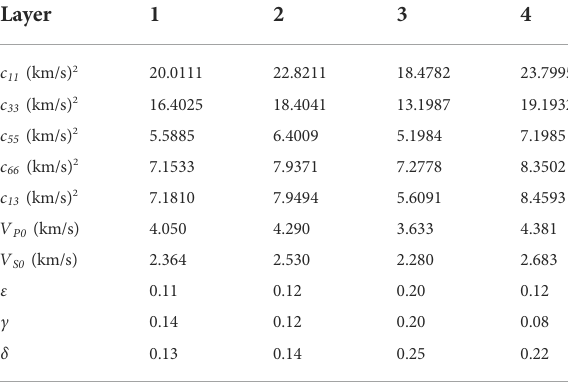
TABLE 1 The anisotropic parameters of the four layers.